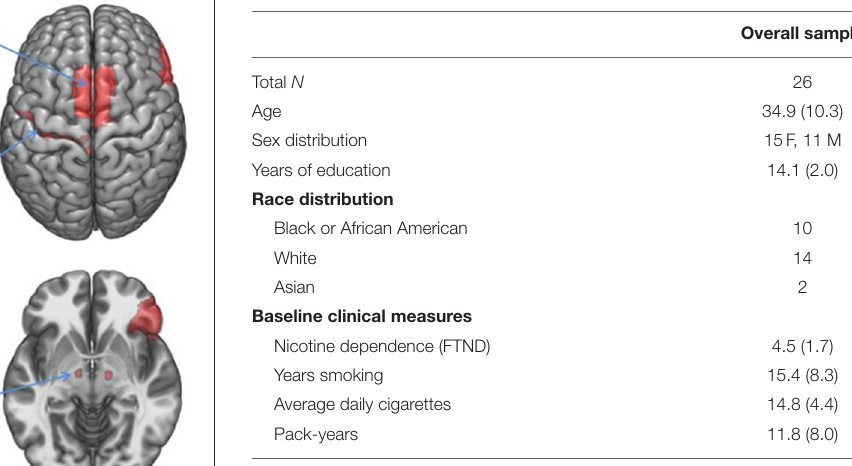
TABLE 1 | Subject demographics and baseline self–report